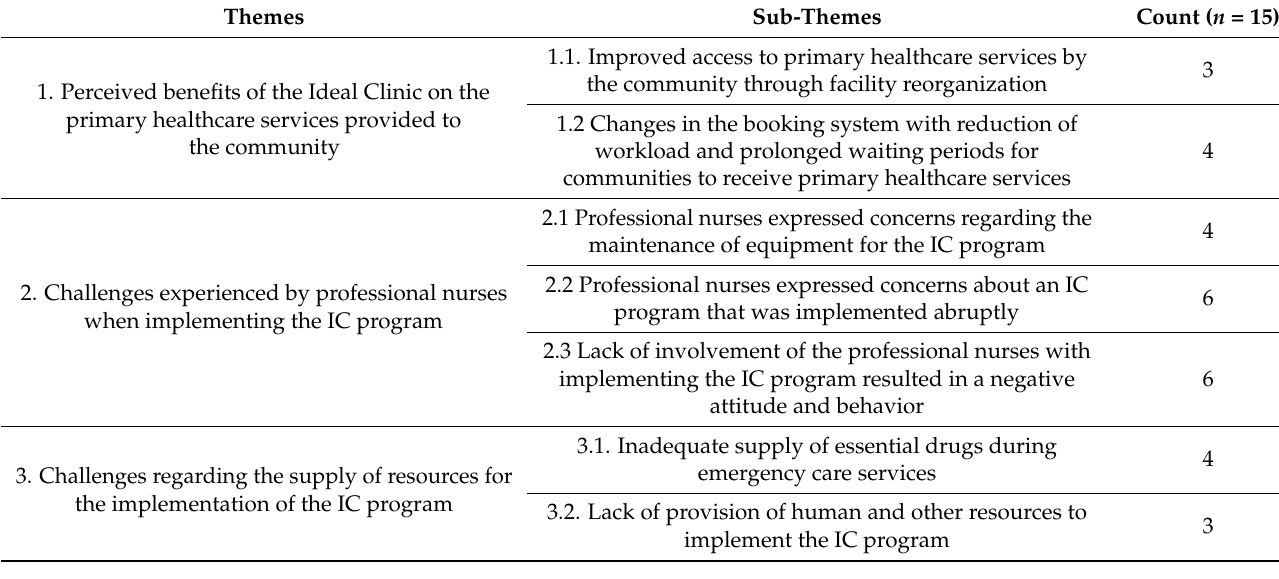
Table 1. Summary of themes and subthemes that emerged from data analysis reflecting professional nurses’ experiences regarding the implementation of the Ideal Clinic